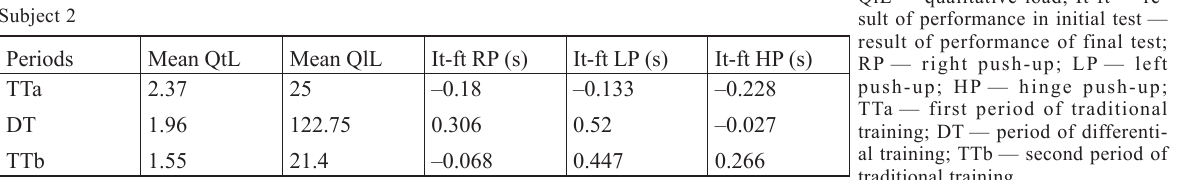
Table 1. Mean load for each sub-pe- riod and difference in performance between the fi rst and the last push- up